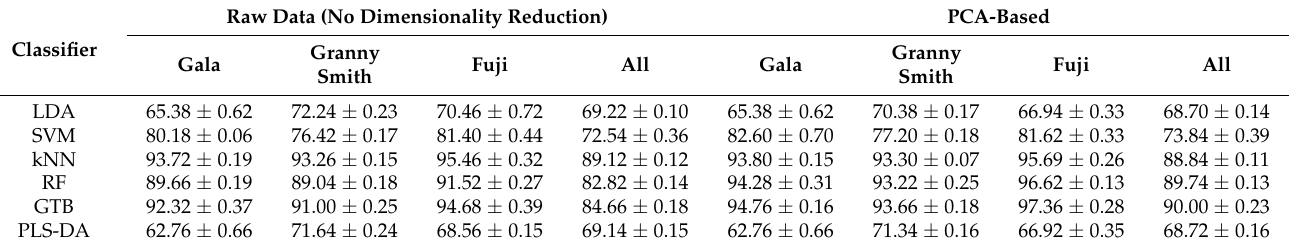
Table 3. Classification accuracy (%) for validation data set based on automatically selected pixels for three apple cultivars.